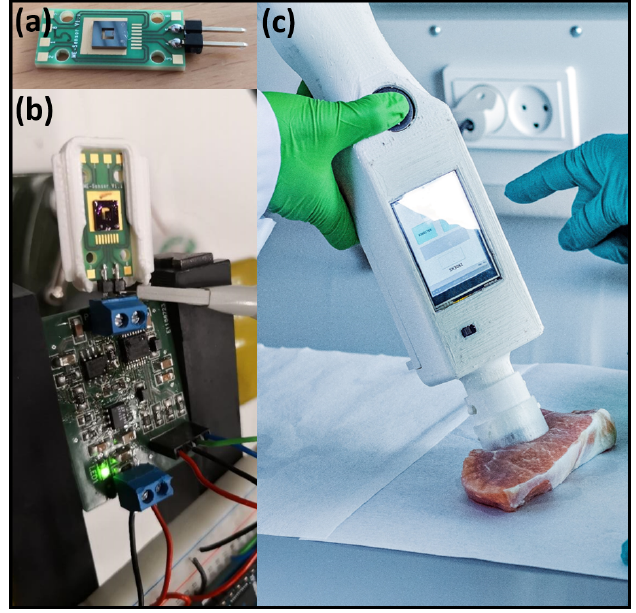
Figure 10. ( a ) Fabricated cantilever. ( b ) Cantilever attached to custom-made impedance analyzer and ( c ) Cantilever on a hand-held electronic